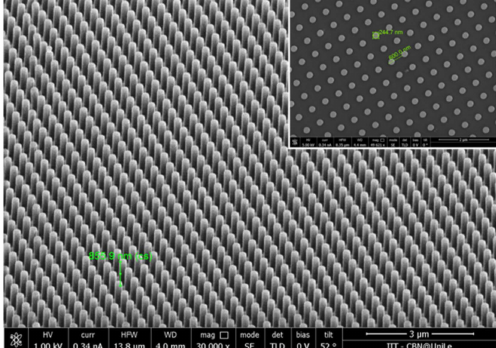
Figure 3. Bird’s eye SEM image of the fabricated device; ( inset ) in-plane detail of the fabricated 2D polymethyl-methacrylate (PMMA) plasmonic nano-pillar array. The measured pillar height is corrected for the